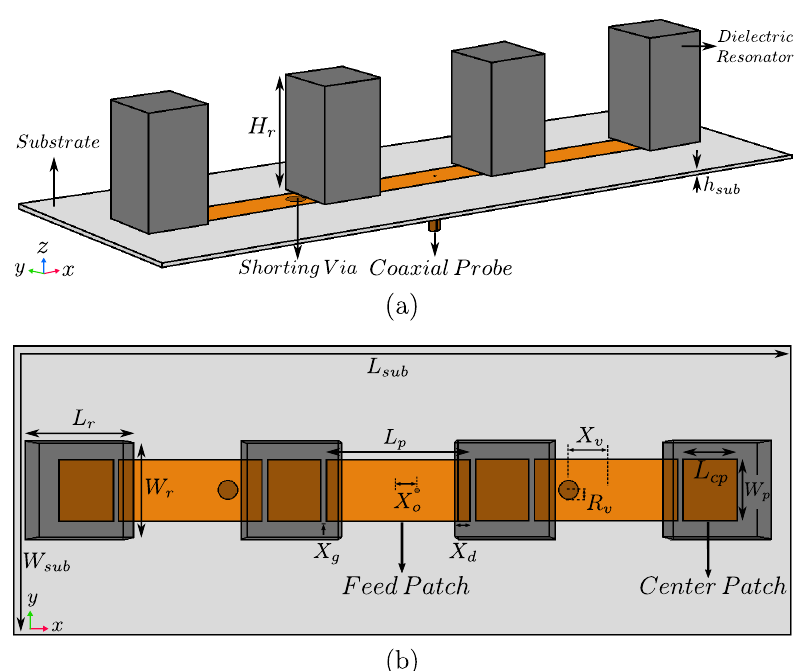
Figure 6. Schematic diagram of proposed four-element standing-wave DRA array: ( a ) 3D view and ( b ) top view with transparent